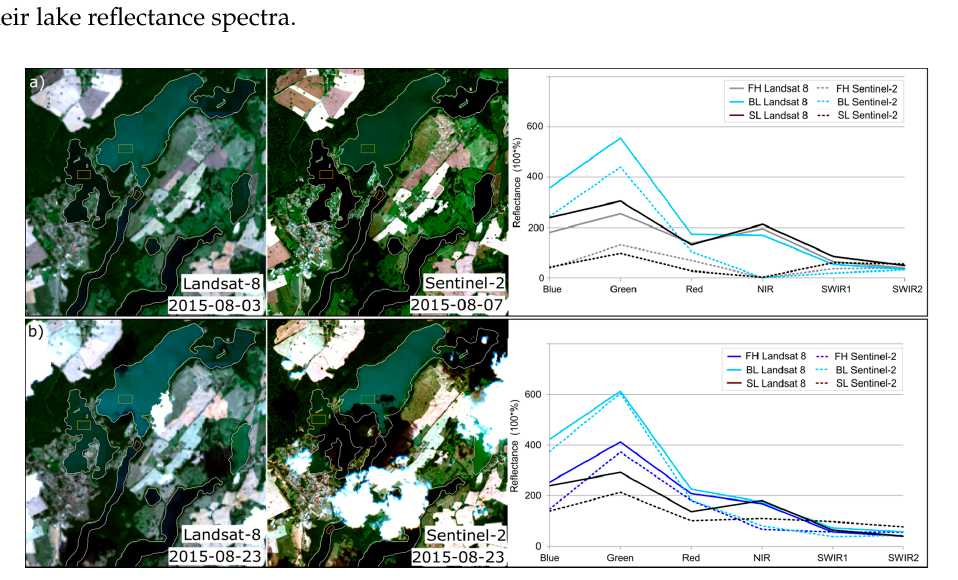
Figure 15. Comparison of two contemporary acquired quasi ‐ true color RGB Landsat 8 and Sentinel ‐ 2 images of Feldberg Lake District (left and middle) and their according mean spectra (right side). In ( a ), the Landsat image was acquired on 3 August 2015; and the Sentinel image on 7 August 2015, in ( b ) both images are acquired on 23 August 2015. The orange rectangles in FH, BL and SL illustrate the ROI for the extraction of the mean reflectance spectra. Landsat spectra are illustrated as solid lines, Sentinel spectra as dotted lines.